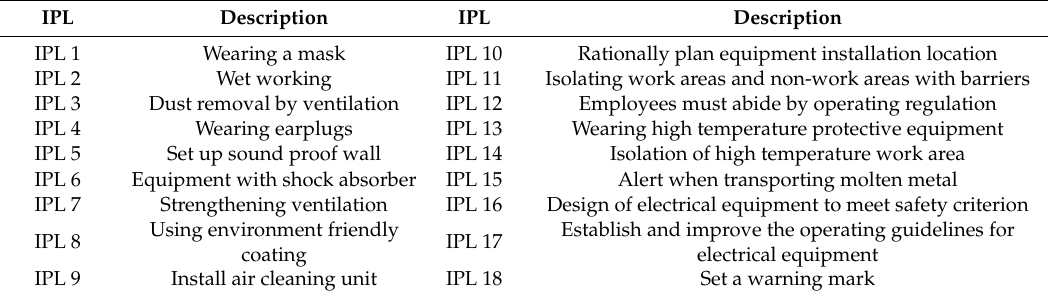
Table 6. Detailed description of